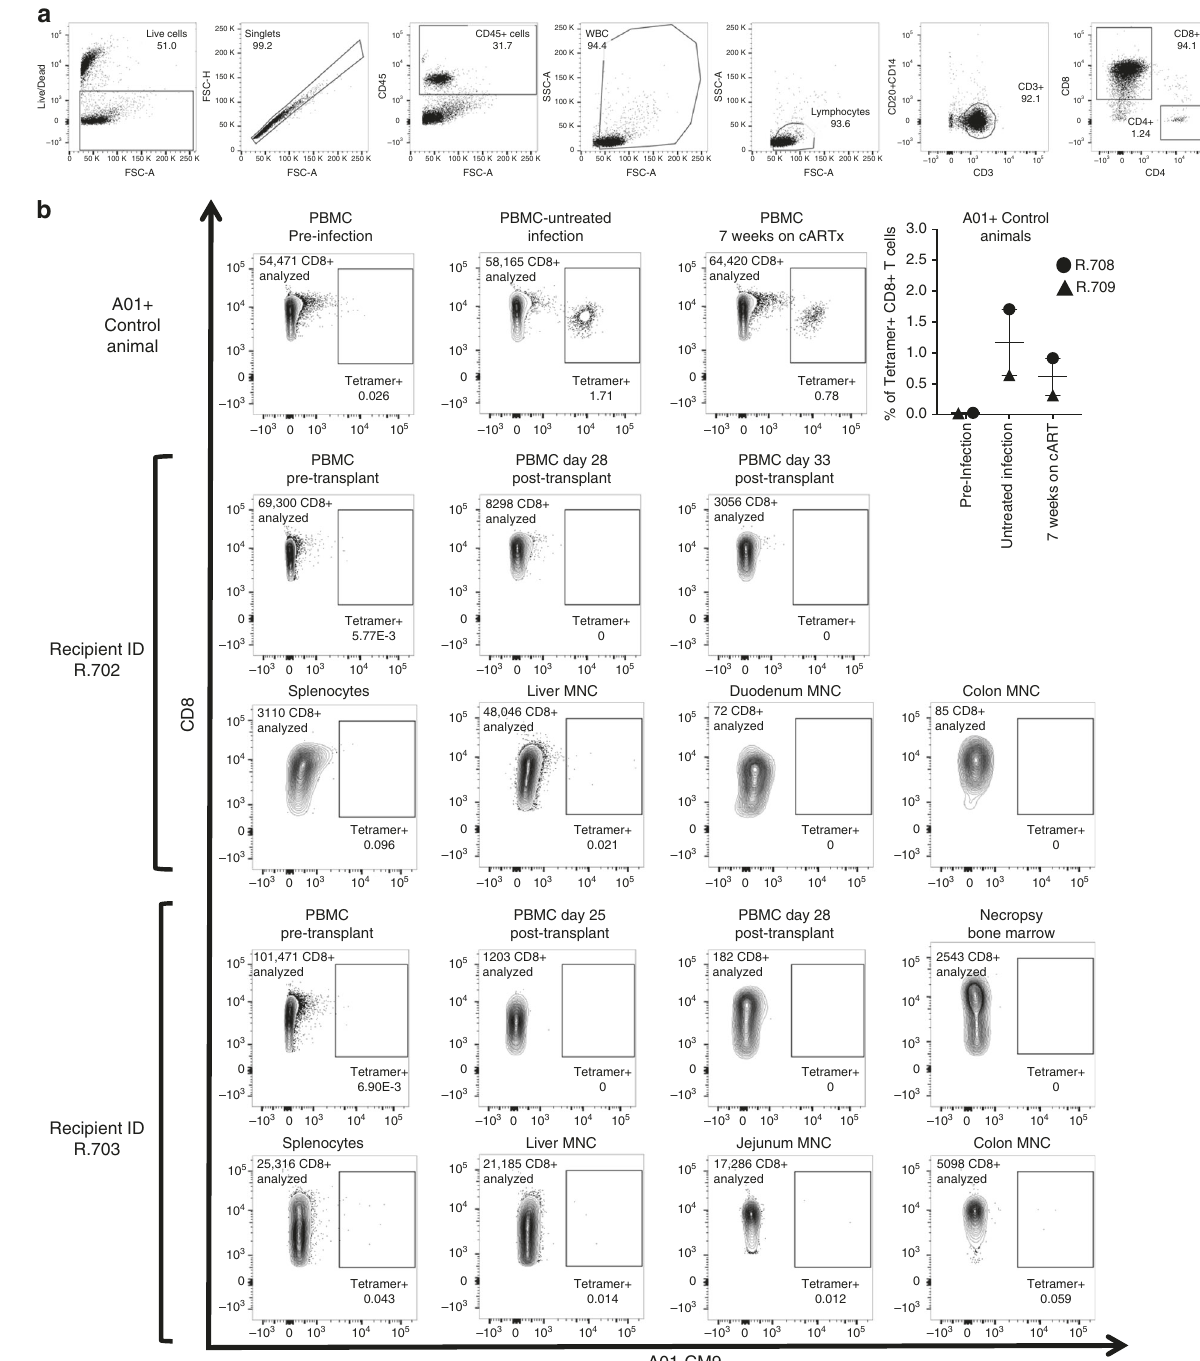
Fig. 4 Virus-speci fi c donor T-cells are not detected in allogeneic transplant recipients. PBMC and tissue-derived MNC were isolated from four animals: a pair of A01 + animals ( ‘ R.708 ’ and ‘ R.709 ’ , with tetramer studies performed pre-infection, at day 90 of untreated infection, and following 7 weeks of cART), and from SHIV + transplant recipients R.702 and R.703, both A01-negative animals who were transplanted with A01-positive donors. a Representative gating strategy from MNC isolated from the jejunum of animal ID R.703. b Tetramer + CD8 + T cells were quanti fi ed (CD45 + CD3 + CD8 + CD14 − CD20 − CD4 − lymphocytes). Error bars represent the mean with